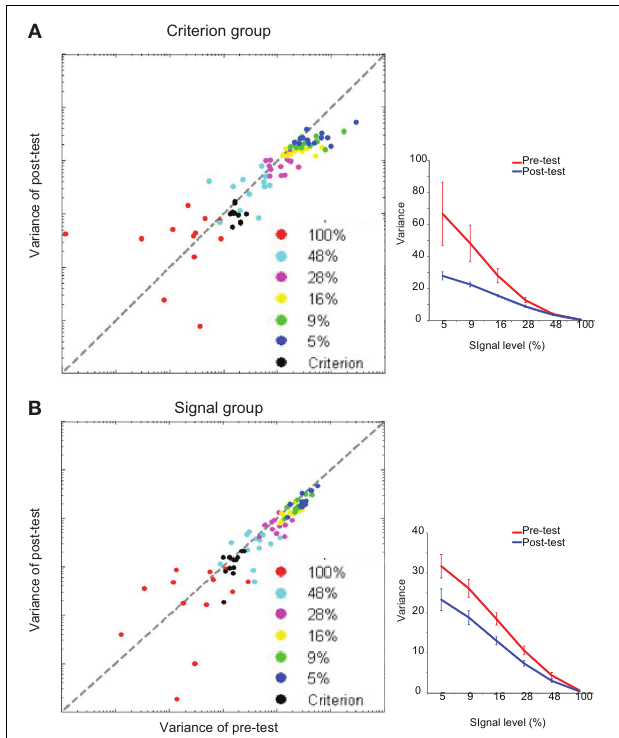
FIGURE 5 | Model fitting results for the signal uncertainty. The signal uncertainty is indexed by the variance of perception. The fitting results are shown for (A) the individual data and group average of the criterion comparison group, (B) the individual data and group average of the signal detection group. Scatter plots show individual results of the model fitting. Each dot denotes one participant’s perception variance at one signal strength condition. Error bars represent the standard errors of the